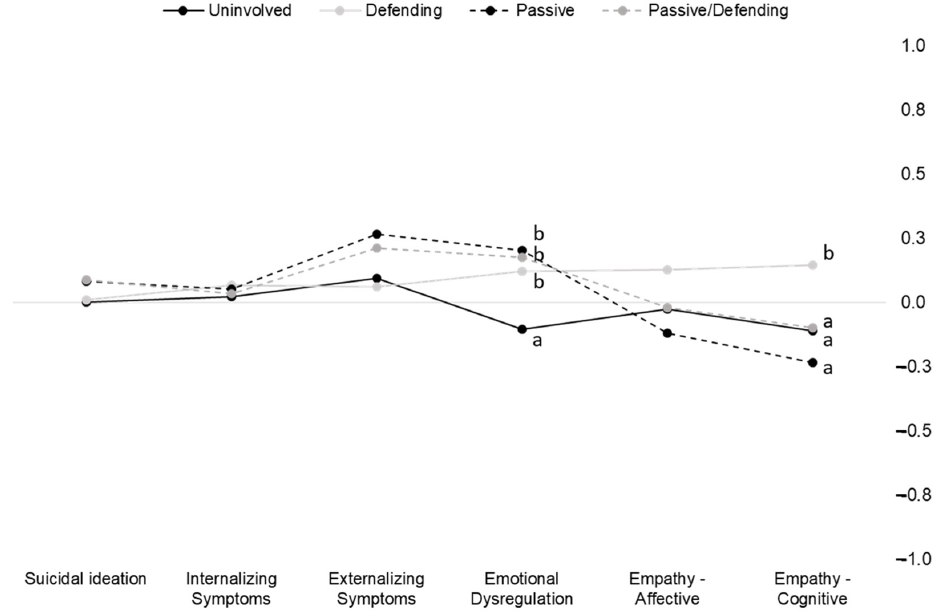
Figure 2. Multivariate profile of psychological distress and empathy by a bystander role in cyberbullying episodes.